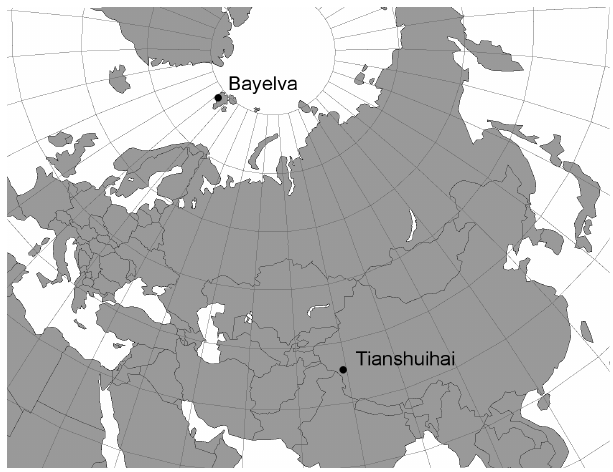
Fig. 1. Locations of the study sites.